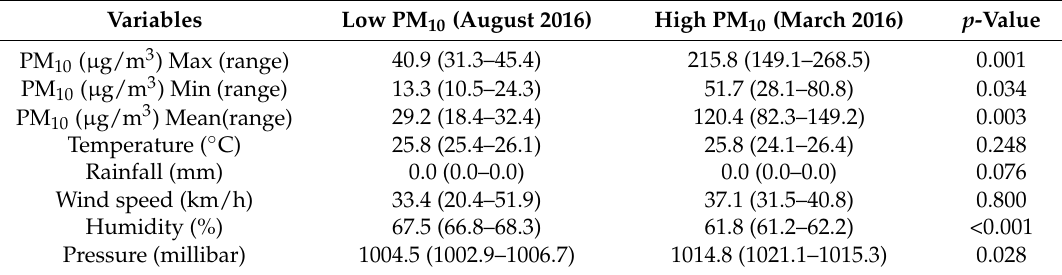
Table 2. Pollutant data between the high PM 10 period (March 2016) and the low PM 10 period (August